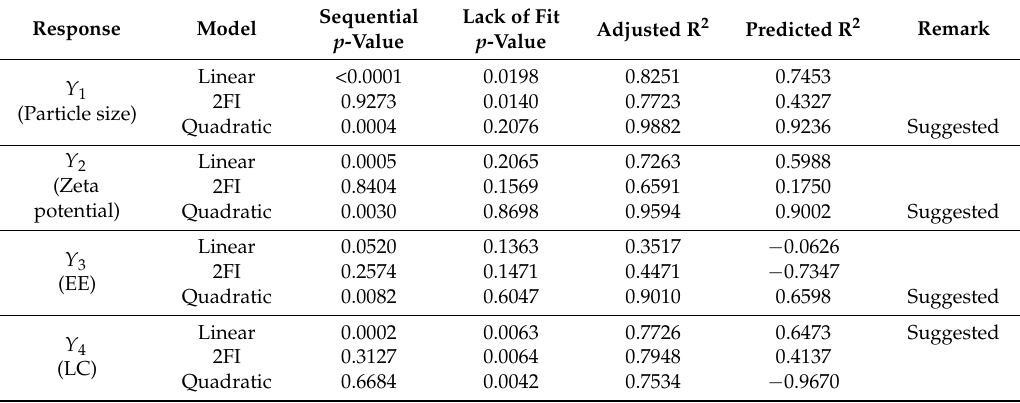
Table 2. Summary of the results of the regression analysis of the